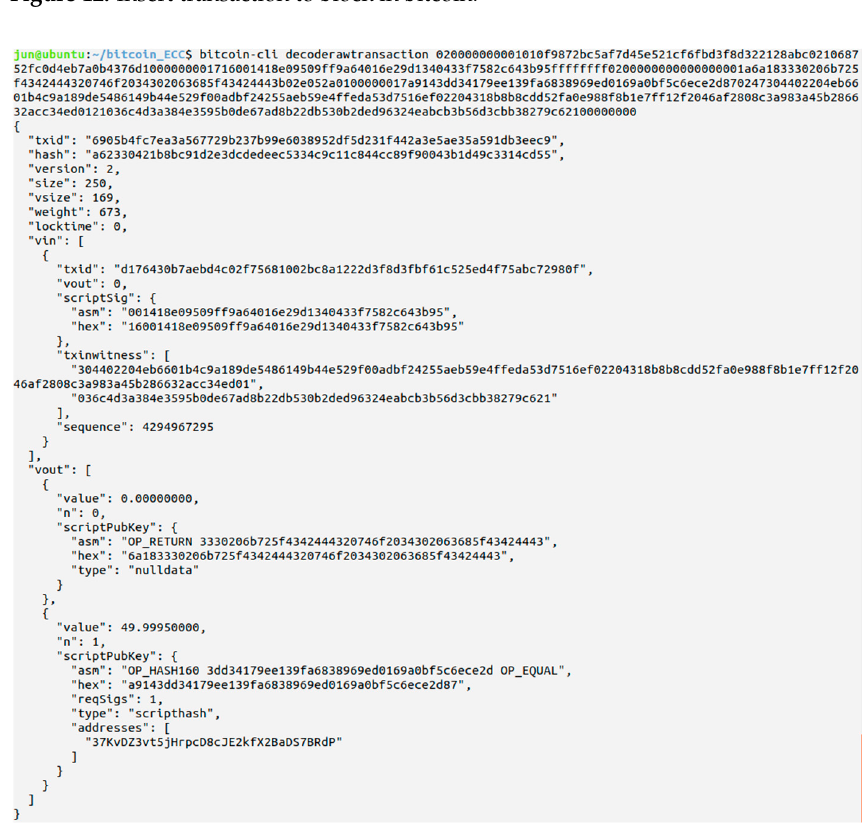
Figure 13. Decode raw transaction in bitcoin.